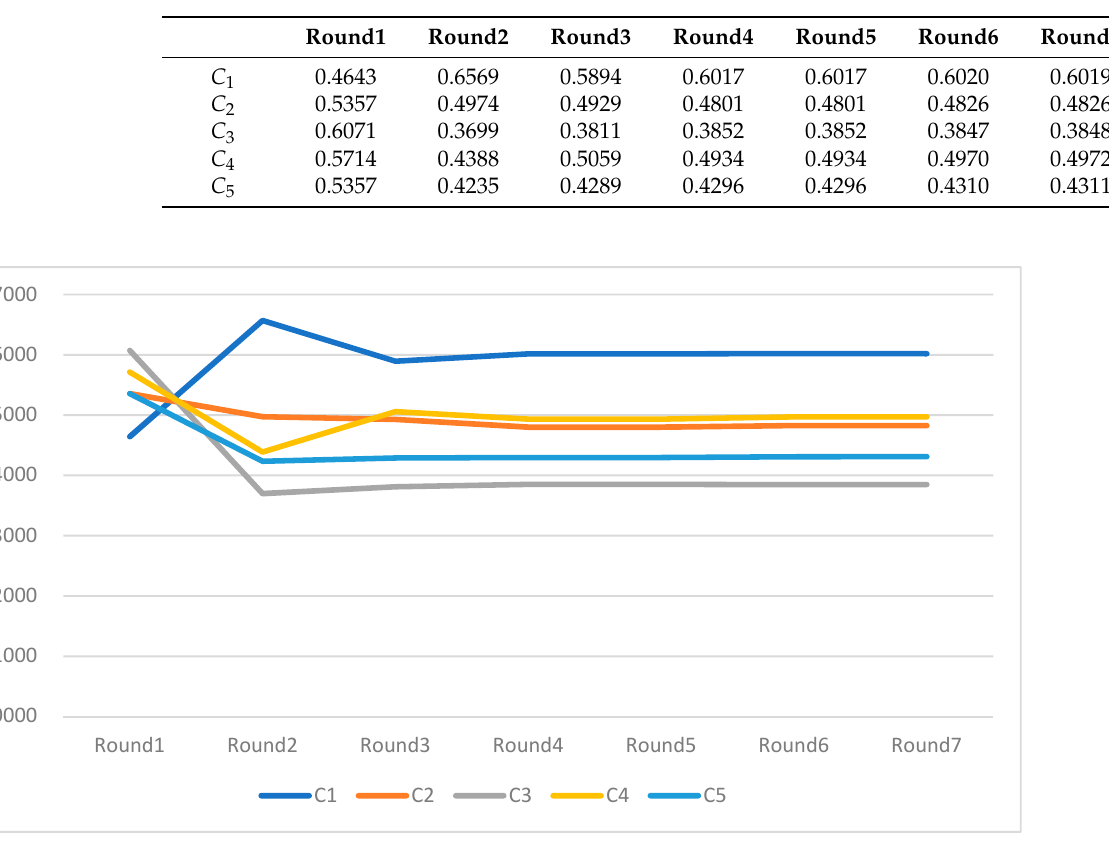
Table 6. Interactive trend of each criterion.